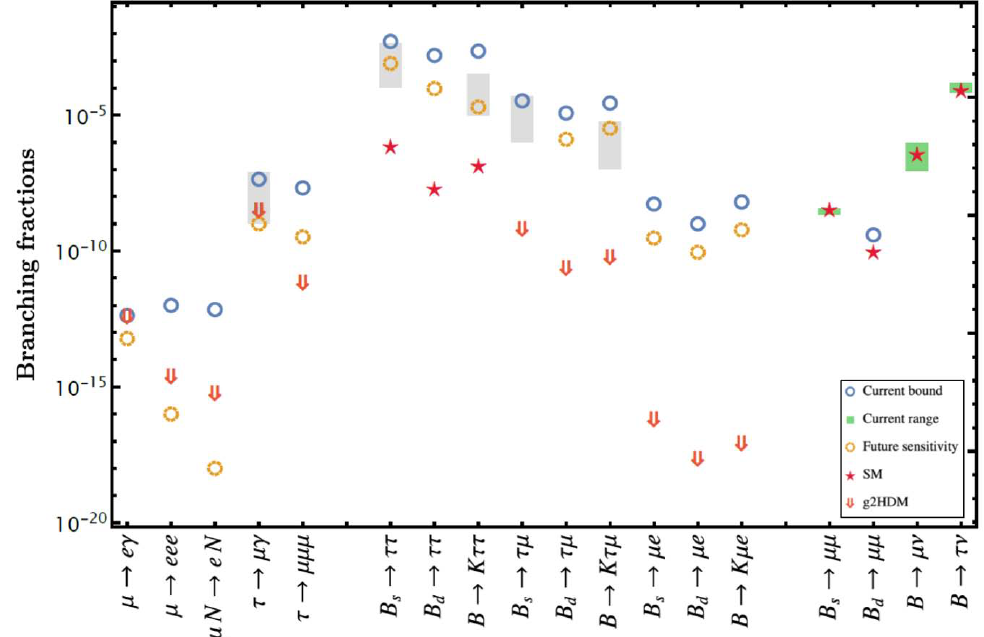
Figure 7. Pictorial table of µ , τ and B decay processes: blue solid (orange dotted) circles for current µµ and B τν , µν ; bounds (future sensitivities); green shaded bands for measured ranges of B s → → grey shaded bands illustrate the five leading predictions of the PS 3 model for B-anomalies; red (cid:63) for SM predictions. The red illustrate g2HDM benchmark projections, using c γ = 0.05, ⇓ m H , A = 300 GeV, ρ µ e = λ e , ρ τµ = λ τ , and ρ ii = λ i , except ρ tt = 0.4. See text for more